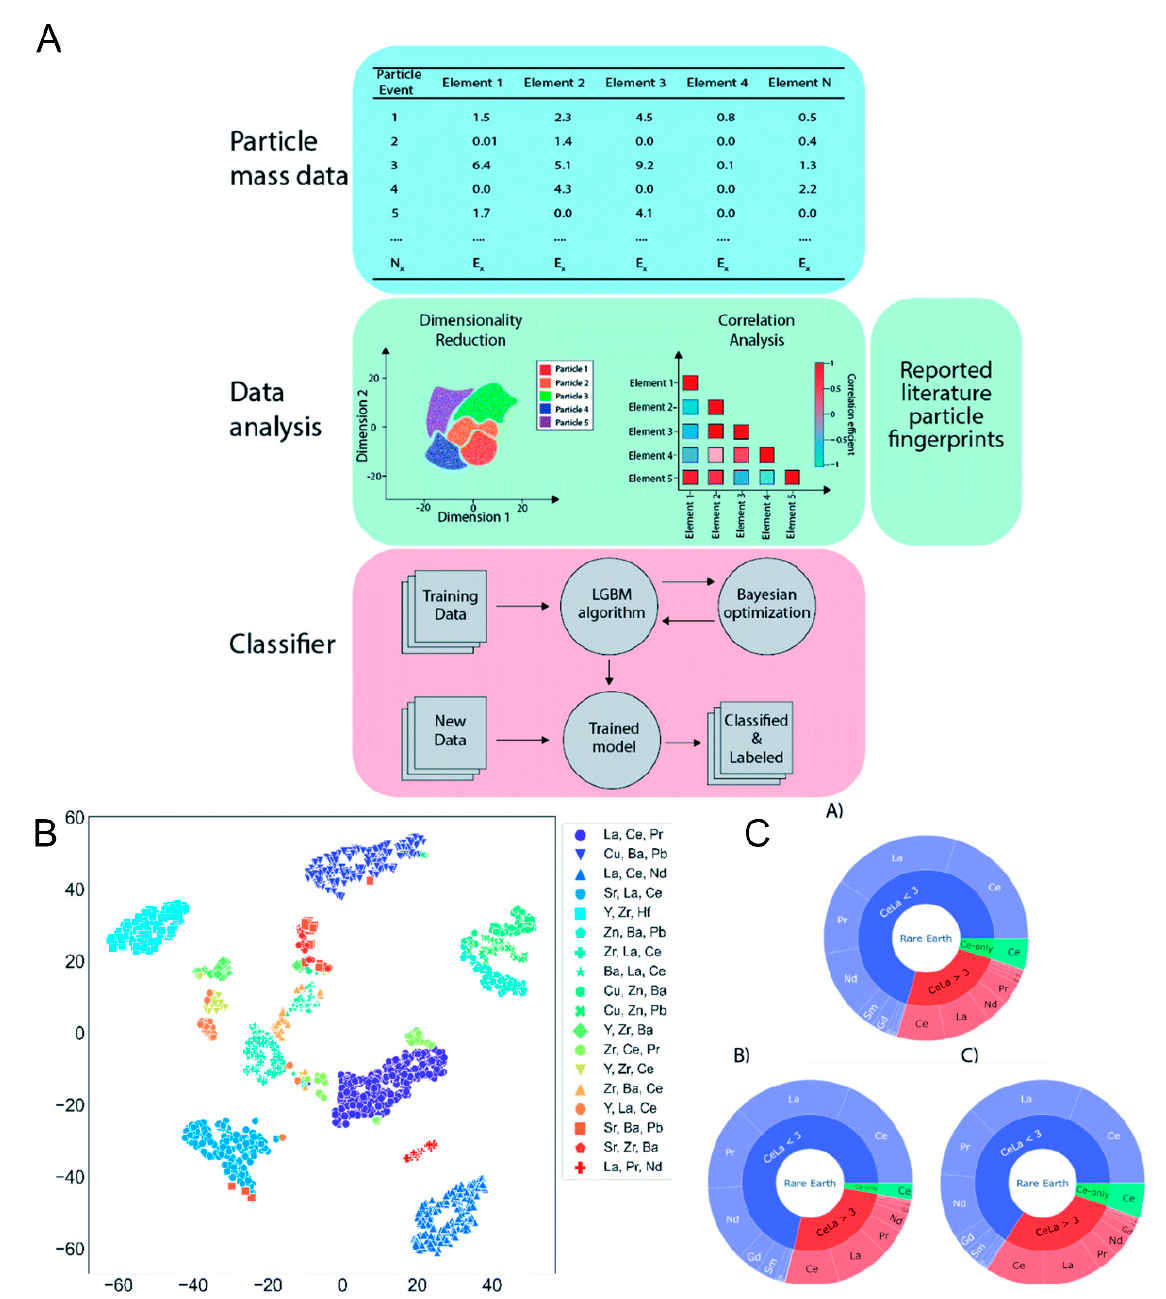
Figure 2. A machine learning model based on Pearson correlation and unsupervised T ‐ distributed random neighbor embedding. A. Data analysis scheme for the multi ‐ element particle analysis using dimensionality reduction (t ‐ SNE), Pearson correlation analysis, and the creation of an automated LGBM classifier from particle mass data in combination with reported particle fingerprint markers. B. t ‐ SNE plot of a sedimentation basin sample; the axis shows the dimension of the reduced dataset. The color and shape indicate specific particle types (i.e., purple circle: SrLaCe containing particles). C. Starburst plots of the particle counts of CeLa ‐ containing particles and their associated elements. Class 1: CeLa containing particles (purple). Class 2: Ce containing particles with a Ce/La ratio greater than 3 (red). Class 3: Ce containing only cerium (green). Sample from ( A ) sedimentation basin, ( B ) road dust, and ( C ) tunnel road dust. (Reprinted with permission from Holbrook T. R J. Anal. At.